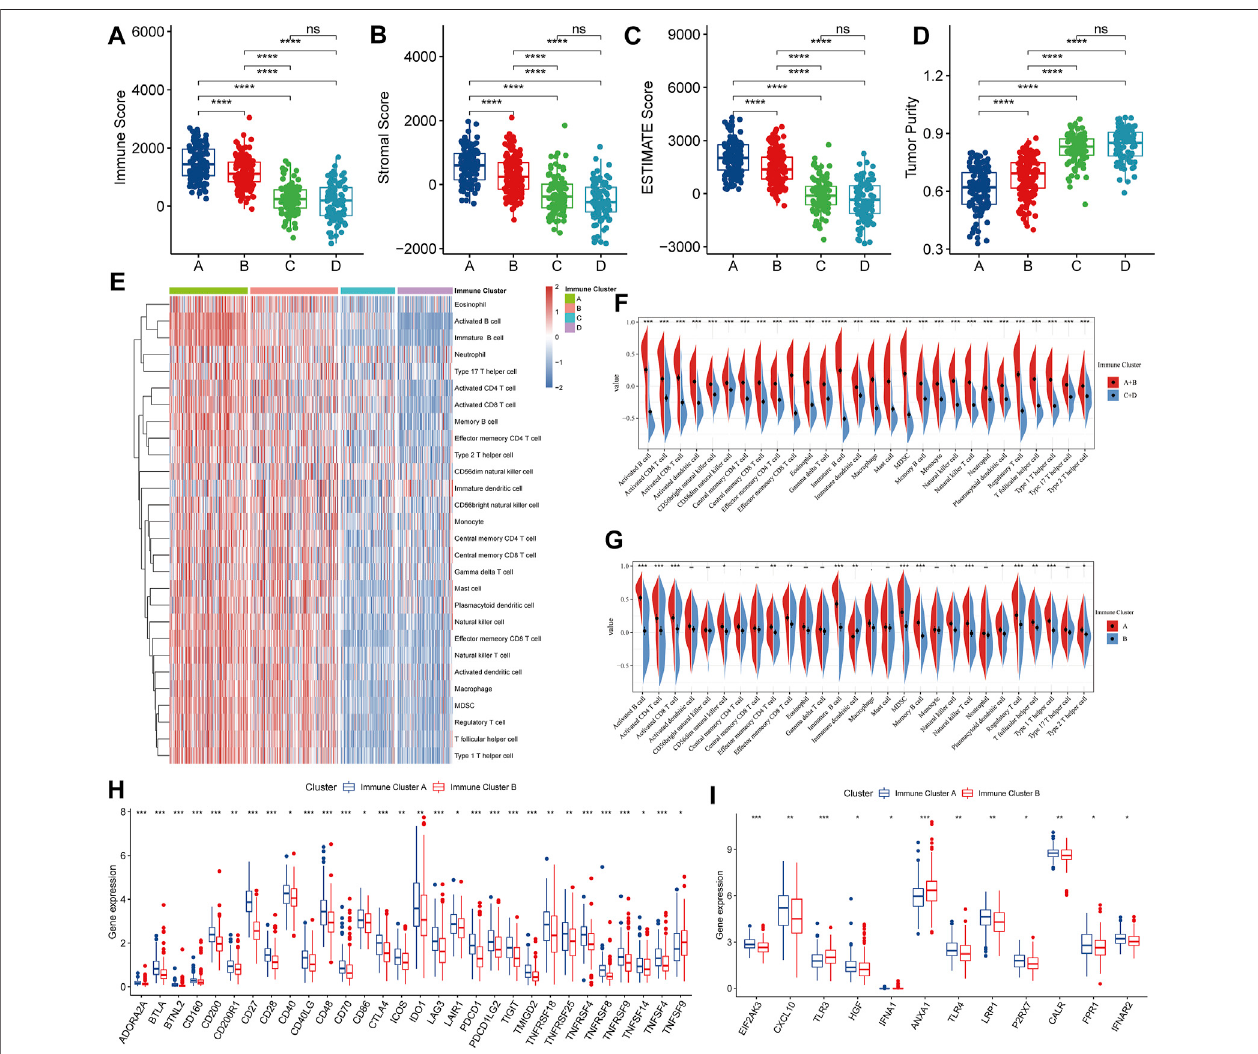
FIGURE 5 | Identi fi cation of tumor immune cell in fi ltration in patients with different clusters. (A – D) Immune-stromal scores and tumor purity of patients in each clusterwereassessedbytheESTIMATEalgorithm. (E) Heatmapofimmunecellin fi ltrationlevelsassessedbasedonssGSEAenrichment. (F – G) Comparisonofimmune cell in fi ltration levels between clusters. (H) Comparison of immune checkpoint expression between clusters. (I) Immunogenic cell death modulators genes expression comparison between clusters.